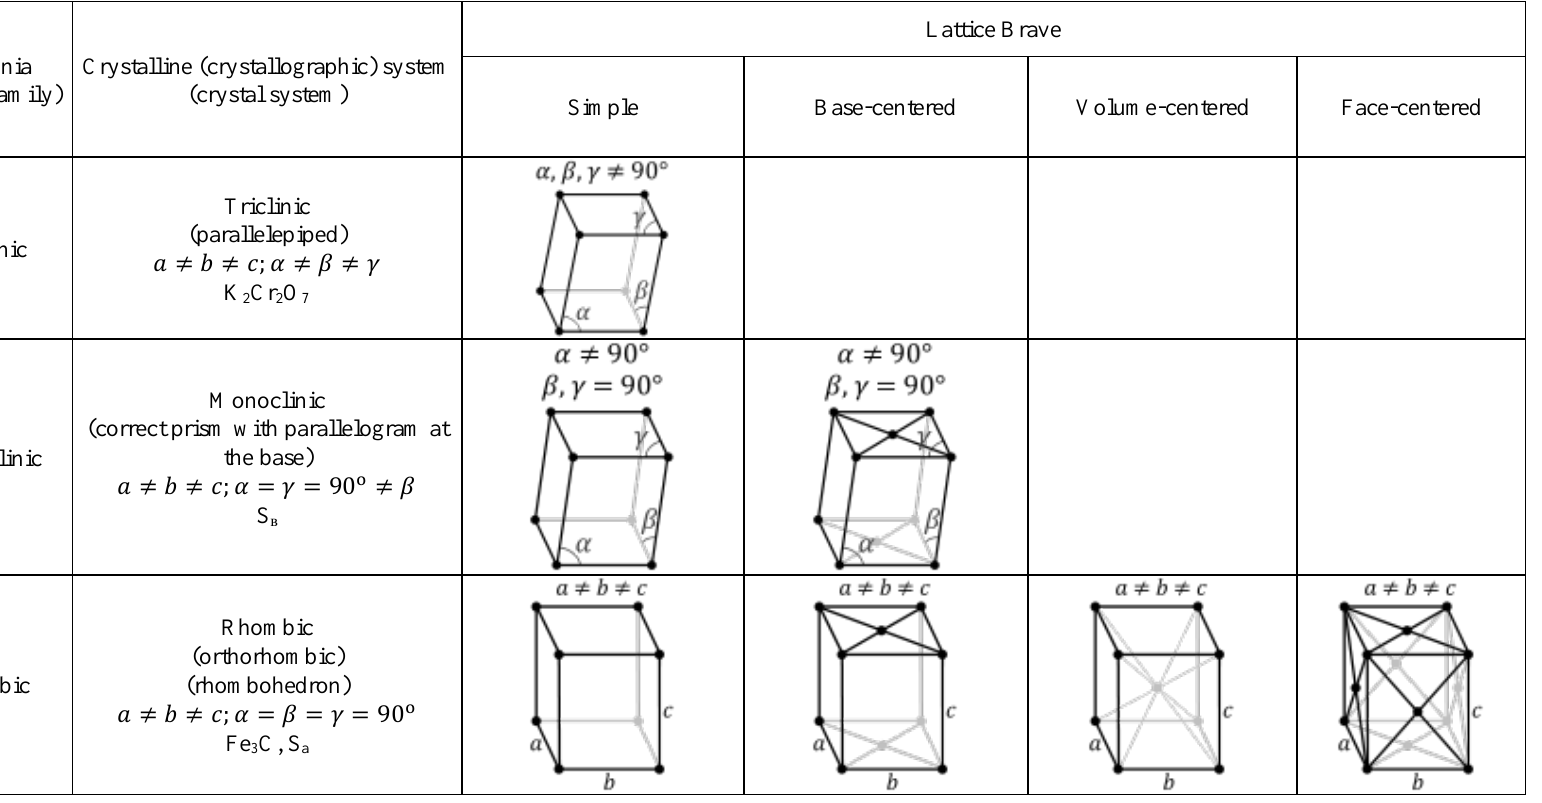
Syngonia (crystal